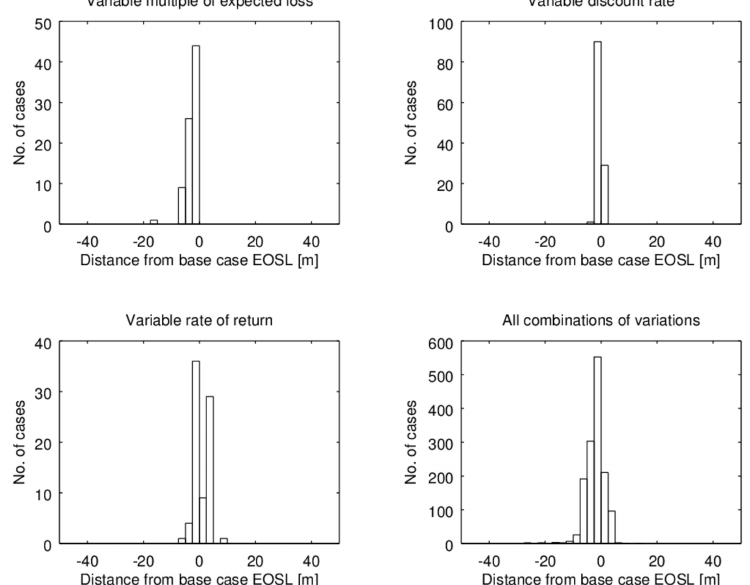
Figure 23. The distance between the EOSL based on the base case parameter values and the EOSL based on different economic constants. Results for profiles in Trincomalee, assuming they all lie in lower-value zones. A negative distance implies a position seaward of the base case